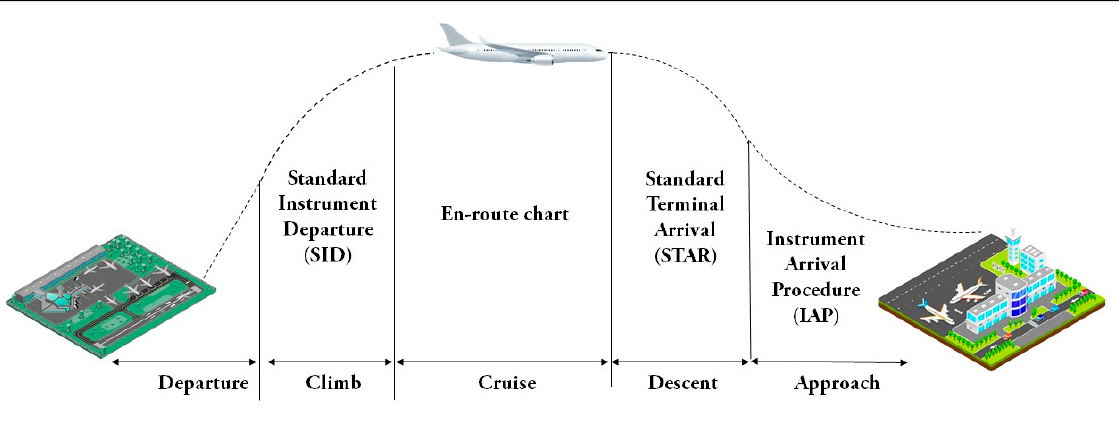
Figure 1. Flight phases and associated procedures. Source: The authors.